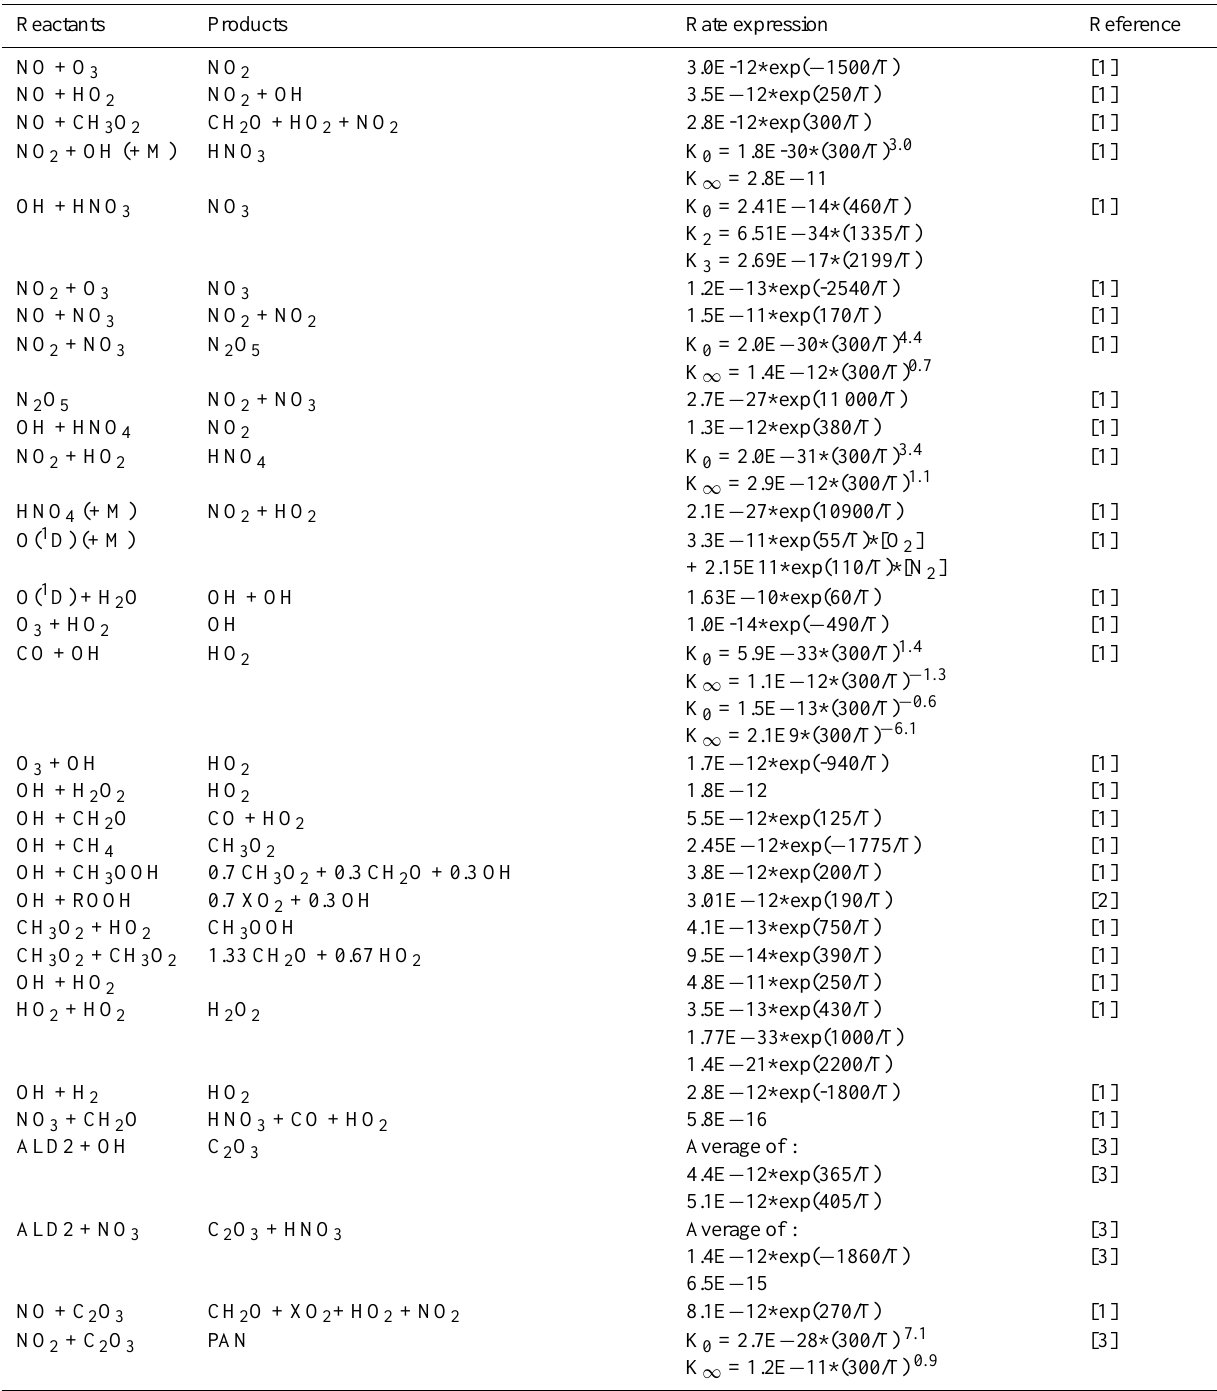
Table 3. The gas-phase chemical mechanism applied in the tropospheric chemistry version of TM5. The reaction products O 2 and H 2 O are not shown. The reactions involving SO 2 , DMS and NH3 have been added onto the modified CBM4 scheme of Houweling et al. (1998) in order to account for the oxidation of the respective species. All reactions of the NH2 radical act as sink processes for the respective radicals and oxidants. The source of the rate data is as follows: [1] Sander et al. (2006), [2] Yarwood et al. (2005), [3] Atkinson et al. (2006), [4]